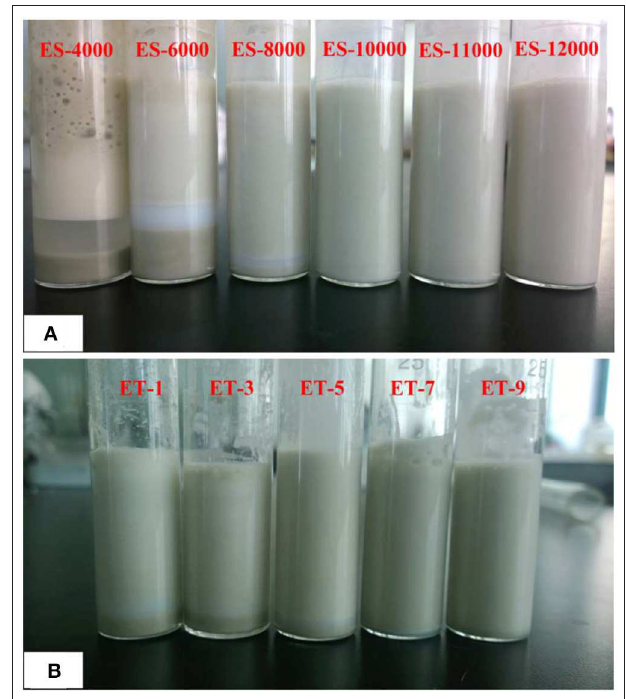
FIGURE 1 | Effects of (A) the homogenizer rotation speed and (B) time on the formation of Pickering-MIPEs. All of the emulsions were stabilized by 5% ATP and 2%